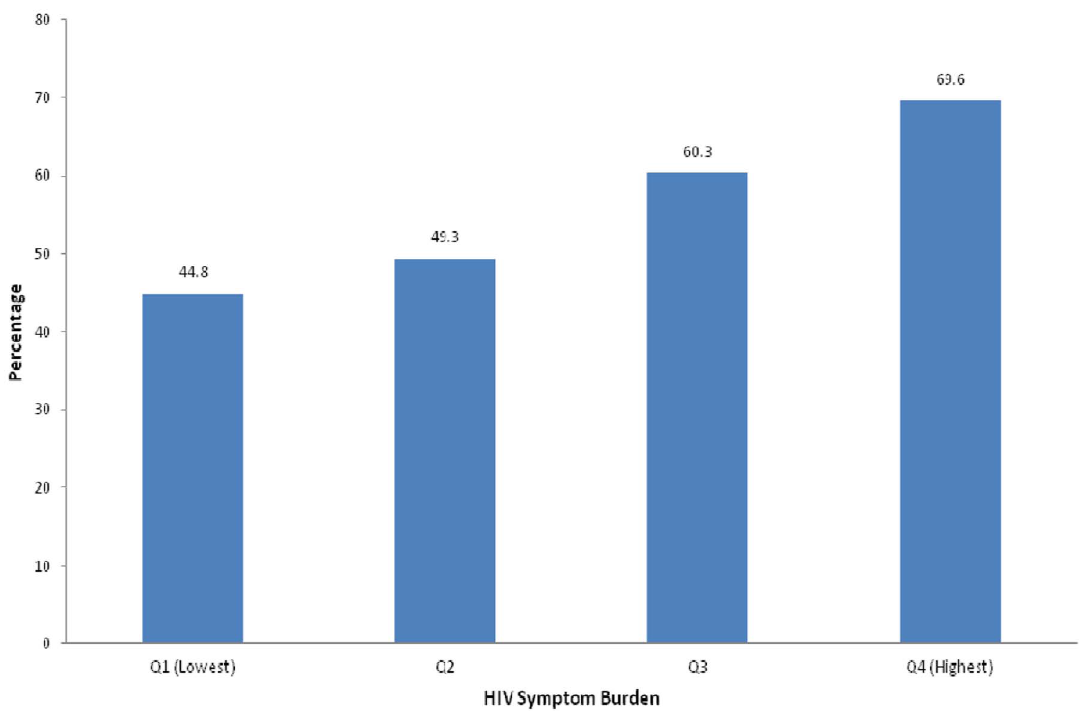
Fig. 2. Prevalence of anemia according to the HIV symptom burden among HIV-positive people in the Kathmandu Valley,